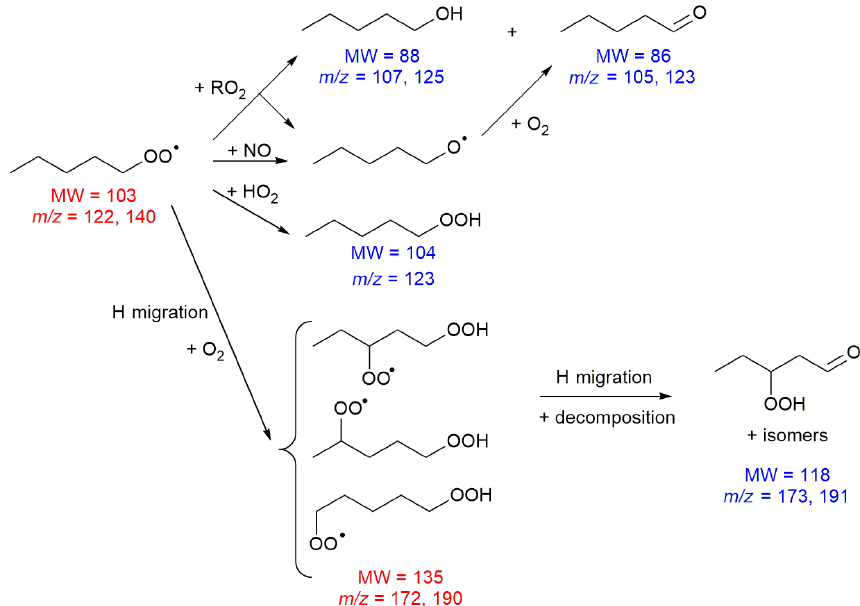
Figure 10. Reaction mechanisms for the 1-pentylperoxy system showing the radicals (MW and m/z in red) and stable products (MW and m/z in blue) observed experimentally (see Fig.